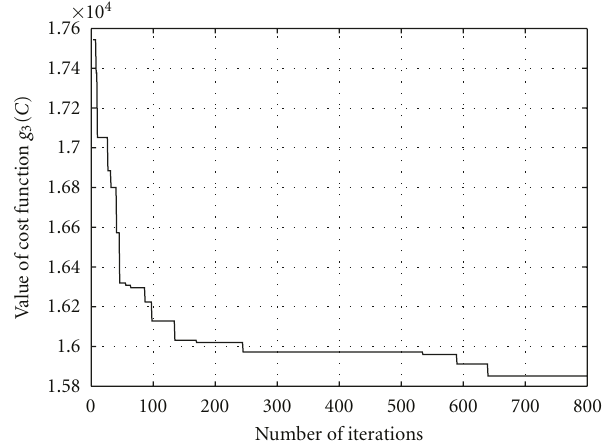
Figure 4: Decrease in g 3 ( C ) versus iterations of simulated anneal- ing.